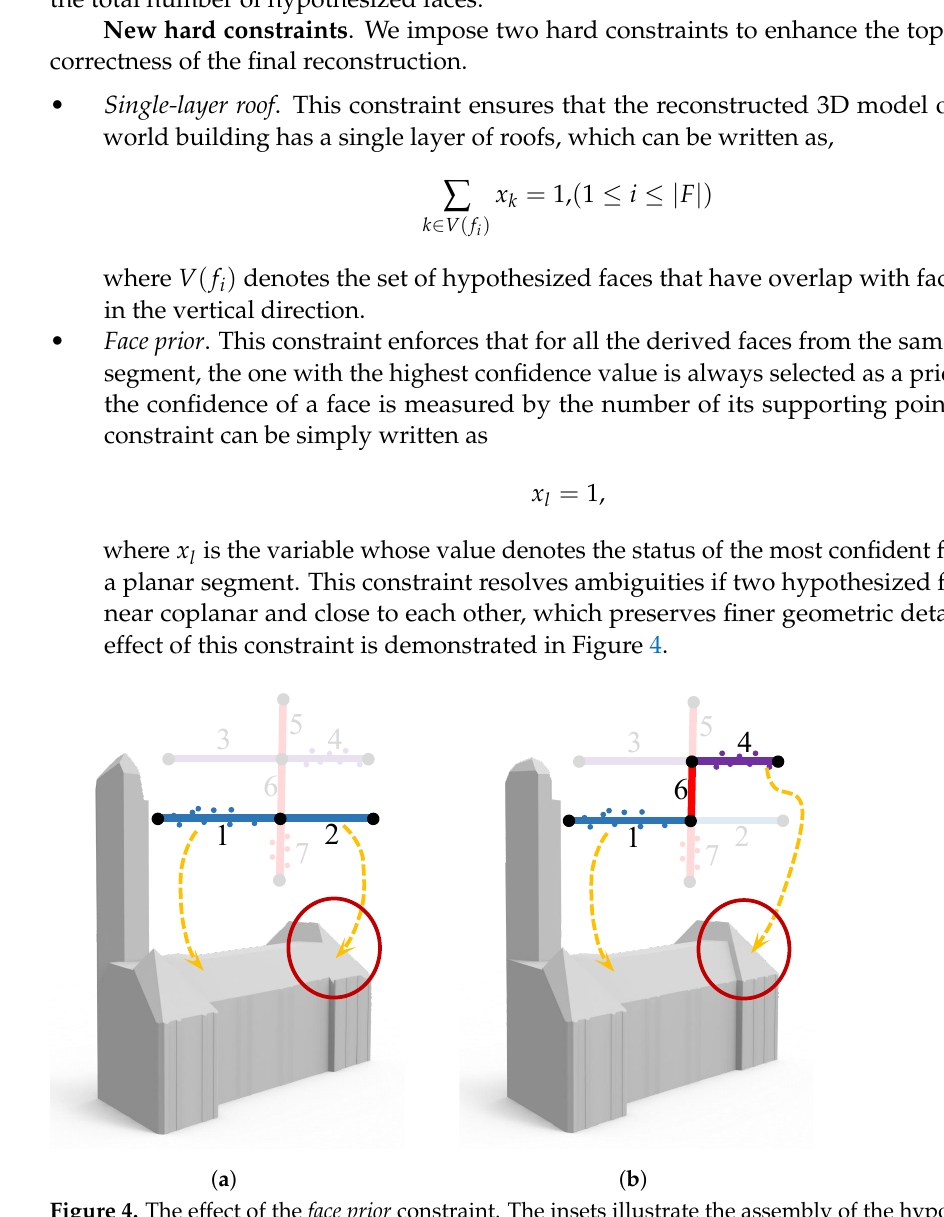
Figure 4. The effect of the face prior constraint. The insets illustrate the assembly of the hypothesized faces in the corresponding marked regions (each line segment denotes a hypothesized face, and line segments of the same color represent faces derived from the same planar primitive). ( a ) Reconstruction without the face prior constraint. ( b ) Reconstruction with the face prior constraint, for which faces 1 and 4 both satisfy the face prior constraint. The numbers 1–7 denote the 7 candidate